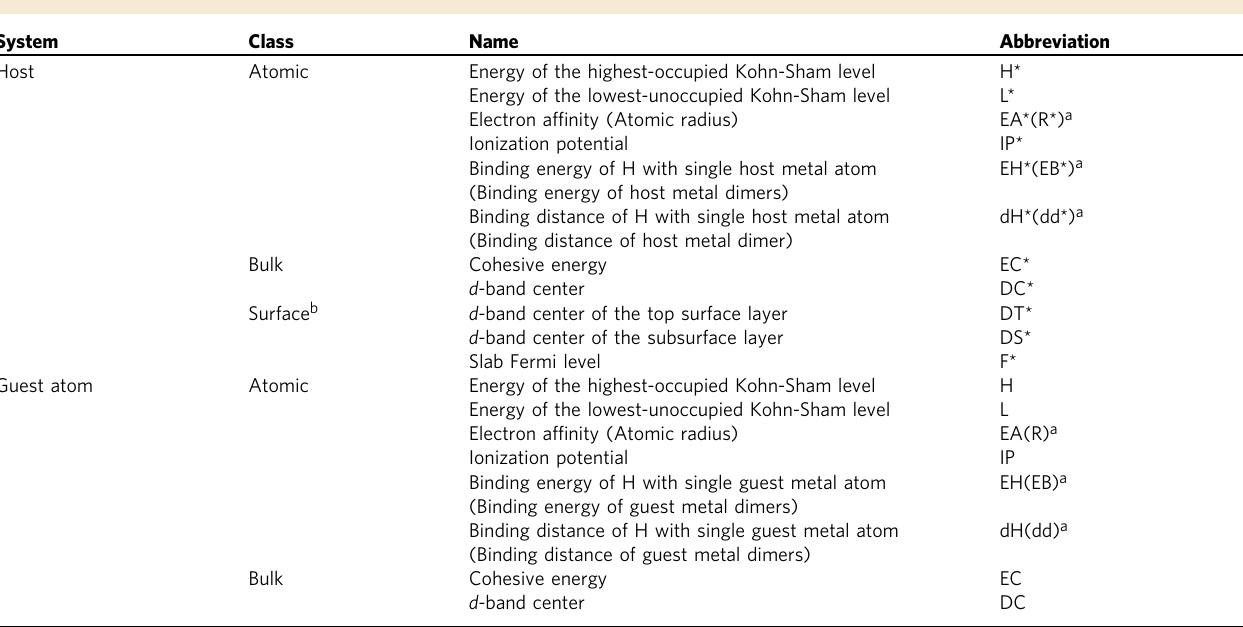
Fig. 1 Correlation between simple descriptors and target properties. Correlation between a H-atom binding energy BE H and the d -band center and b the H 2 dissociation energy barrier E b and the H 2 dissociation reaction energy for Ag(110) based SAACs. Only most stable adsorption sites are included (the hollow site for all systems on this plot). The SAACs inside the blue dotted circle in b signi fi cantly reduce E b while reducing reaction energy only moderately. Table 1 Primary features used for the descriptor